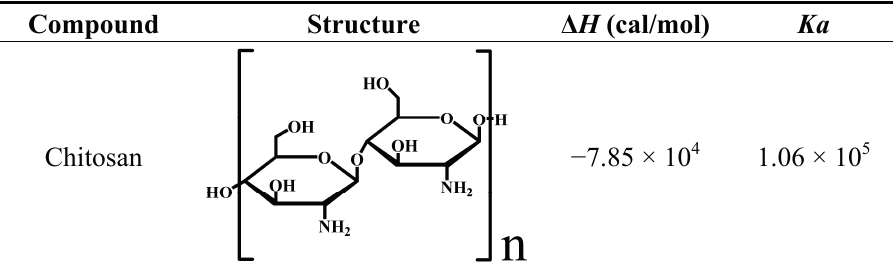
Table 1. Study on the interactions between chitosan and milk proteins using isothermal titration calorimetry at 30